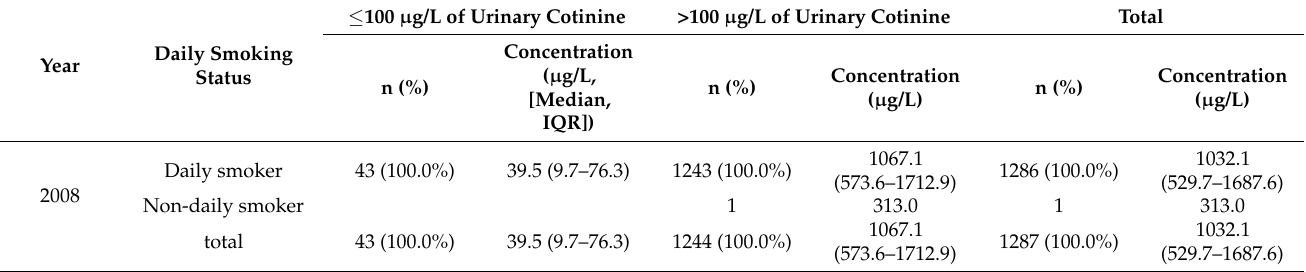
Table 2. The comparison between self-report for daily smoking status and urinary cotinine in current